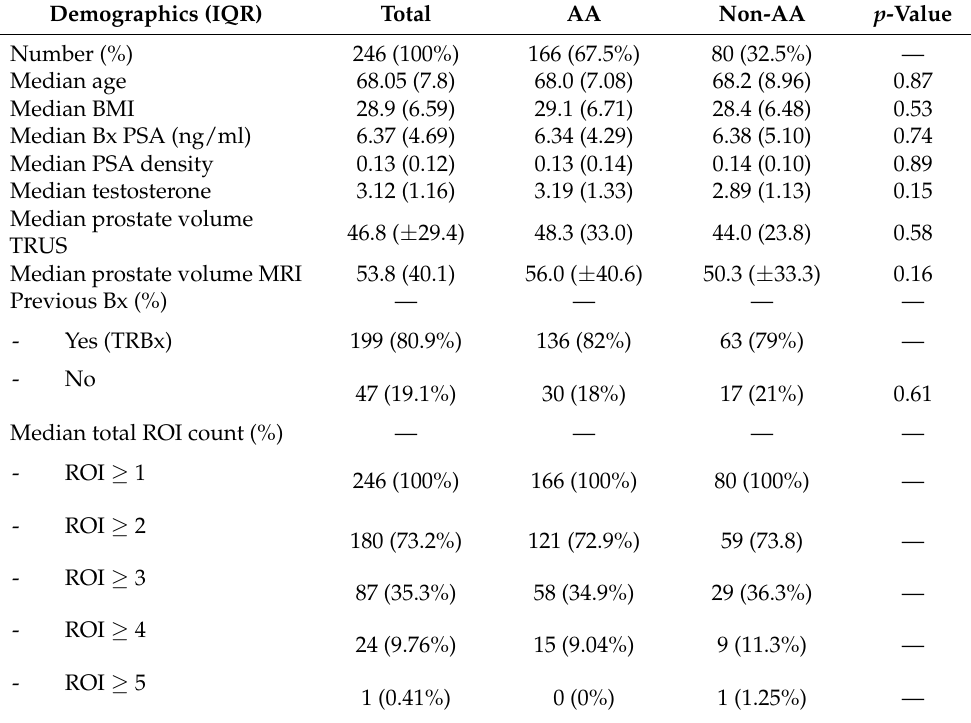
Table 1. Patient cohort demographic and ROI characteristics.